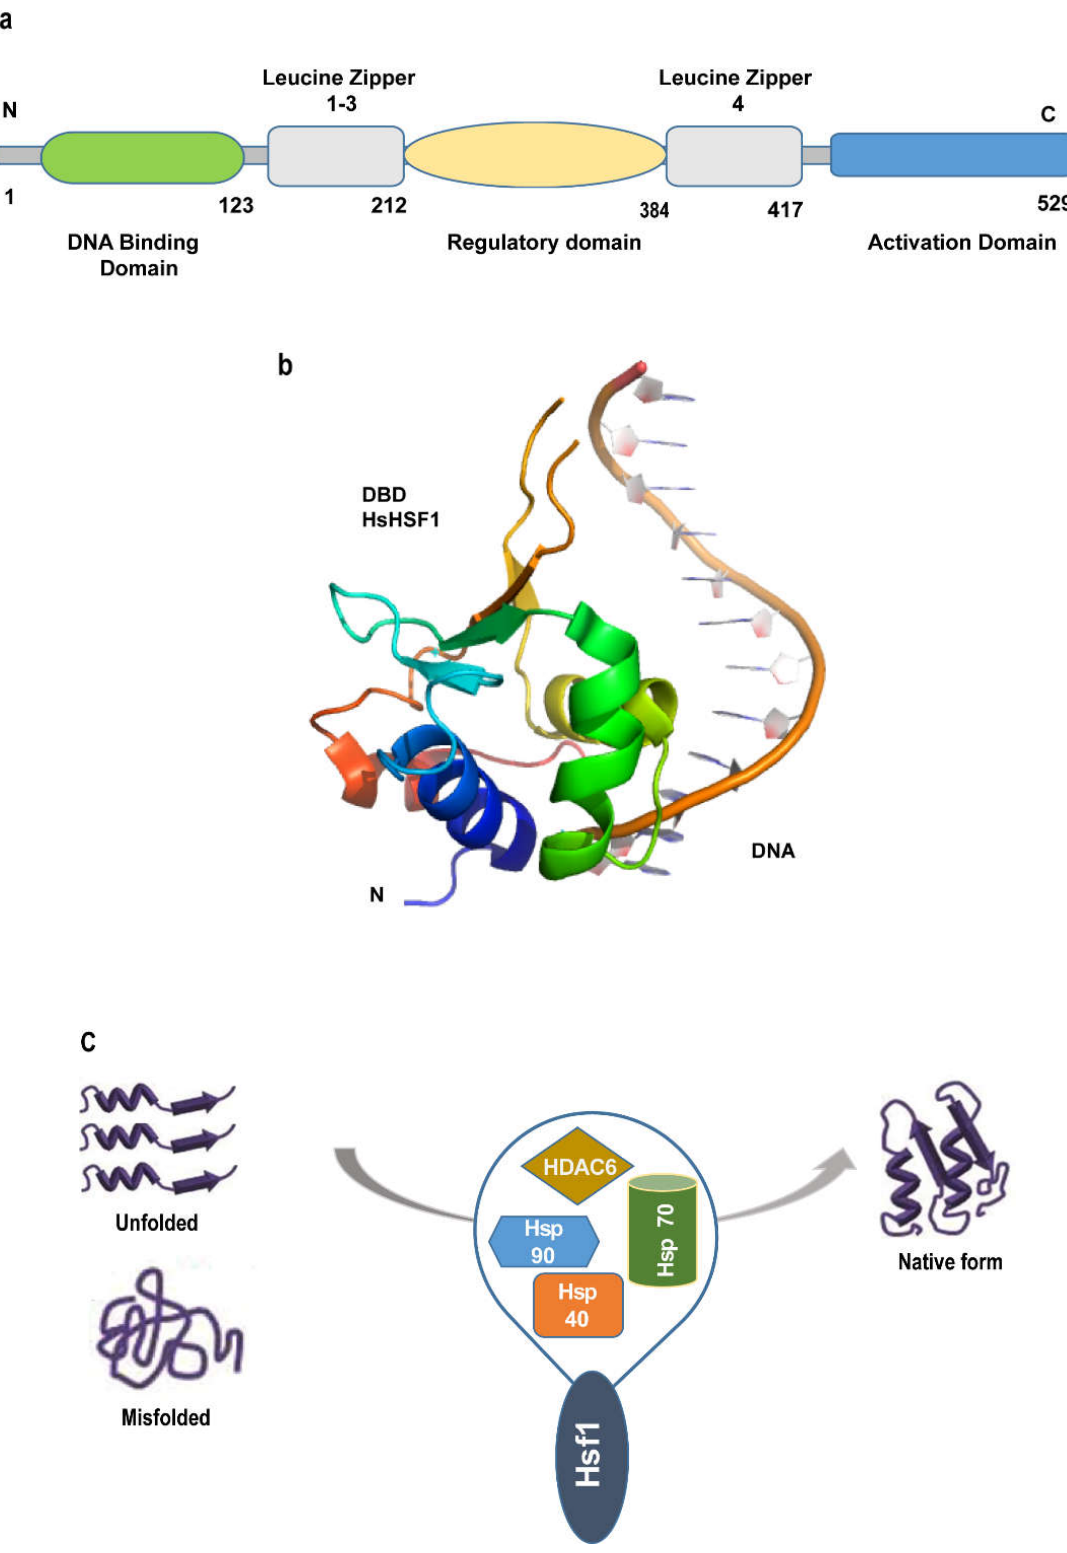
Figure 2. ( a ) Domain structure of HSF1; ( b ) Crystal structure of Human HSF1 with DNA (PDB: 5D5U); ( c ) HSF1 with the help of co-chaperones can prevent toxic buildup of unfolded proteins and assist in refolding of misfolded proteins to prevent aggregation and promote cellular